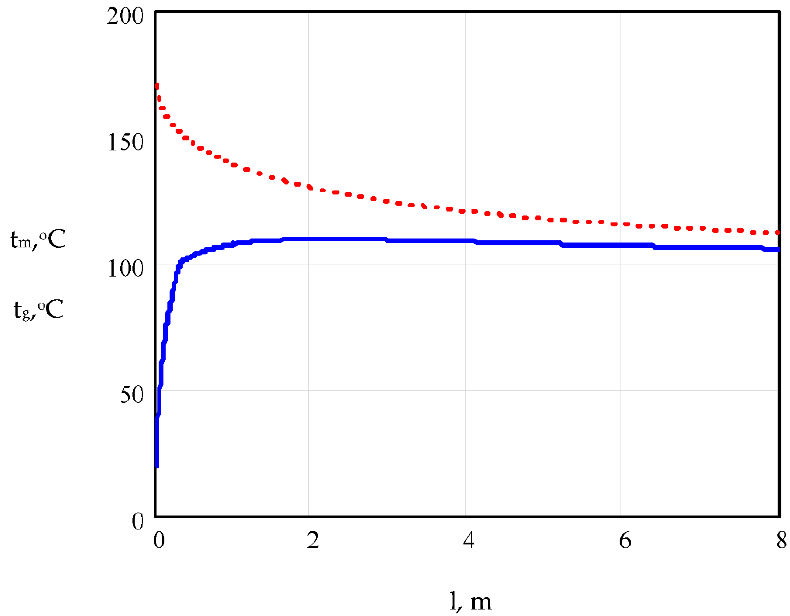
Figure 13. Steam temperature (dotted line) and tobacco temperature (solid line) in the function of the apparatus length. Table 3. Results for a superheated steam pneumatic dryer of tobacco. Dimension and Parameters of